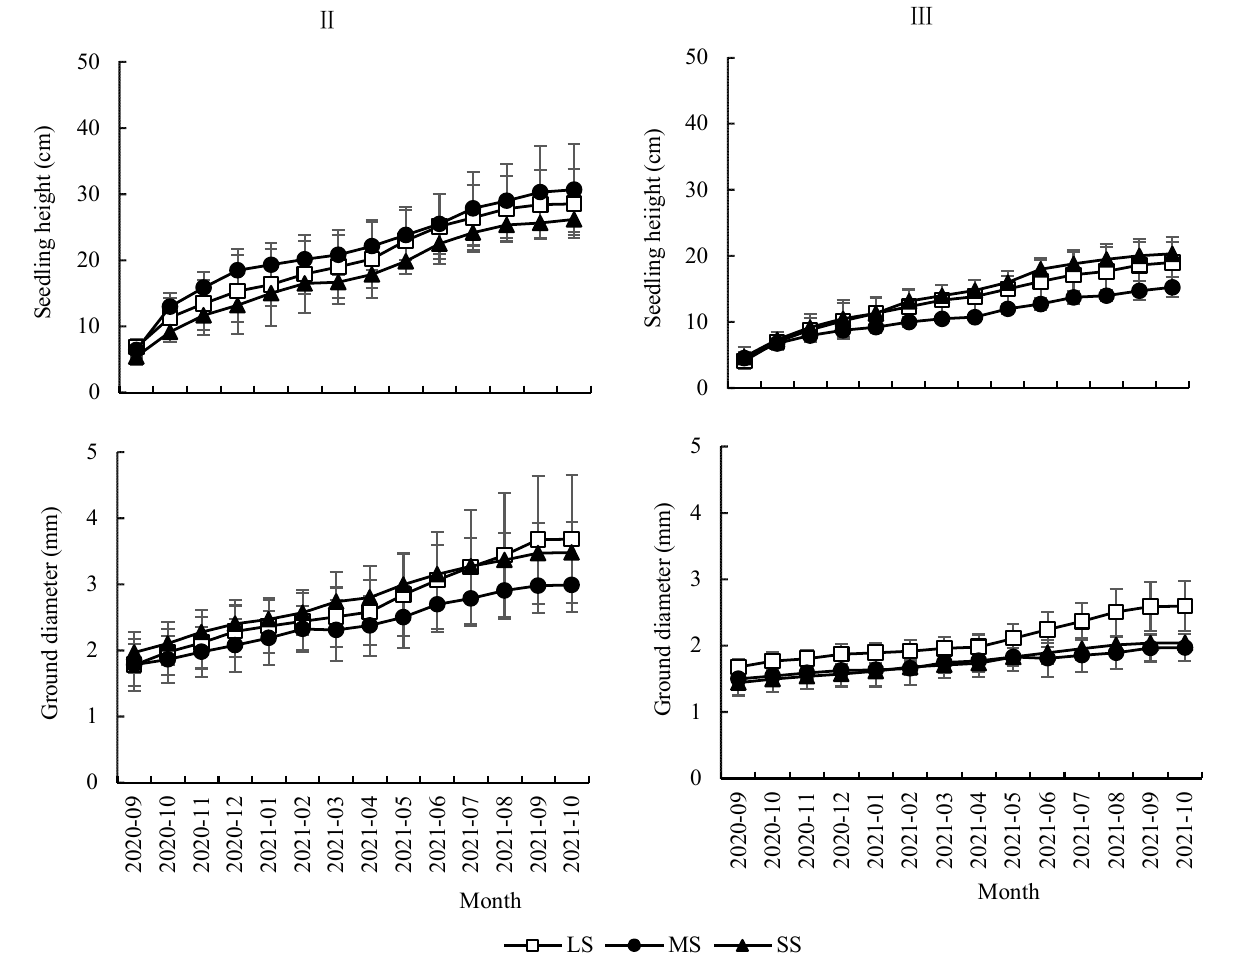
Figure 4. Monthly dynamic changes of seedling height and ground diameter of Quercus acutissima seedlings from different sizes of seeds under different forest gaps. LS: large seed; MS: medium seed; SS: small seed.